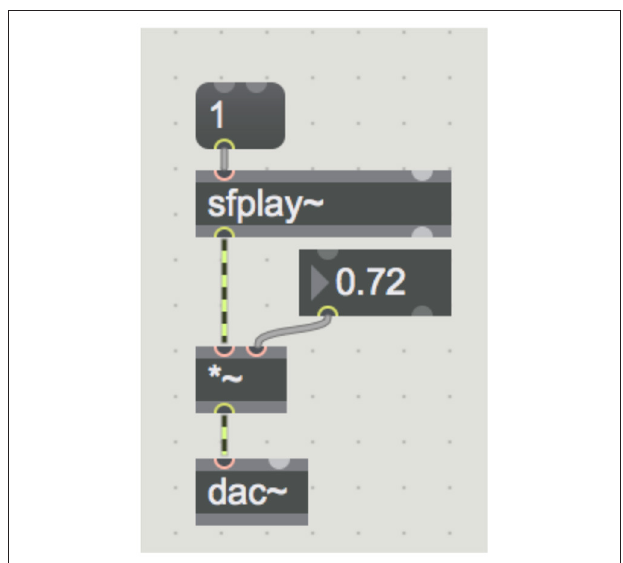
FIGURE 6 | A simple “patch” in Max/MSP to play a sound file with volume